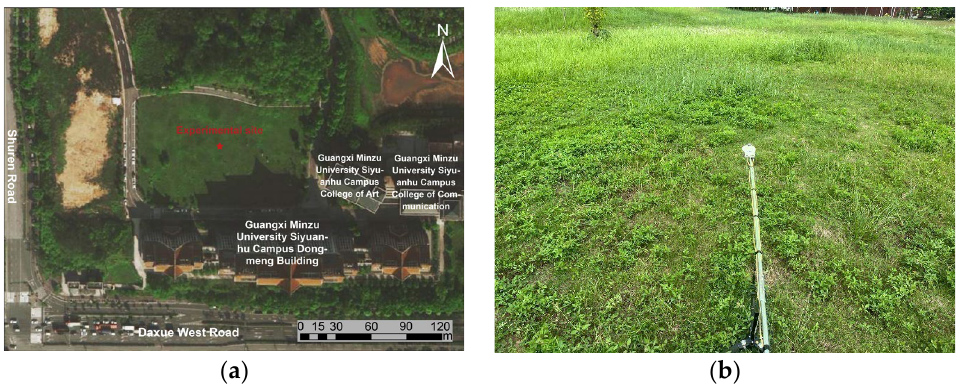
Figure 1. The measuring site ( a ) Aerial view of the testing site, ( b ) Photo about the setting of the radiometers.